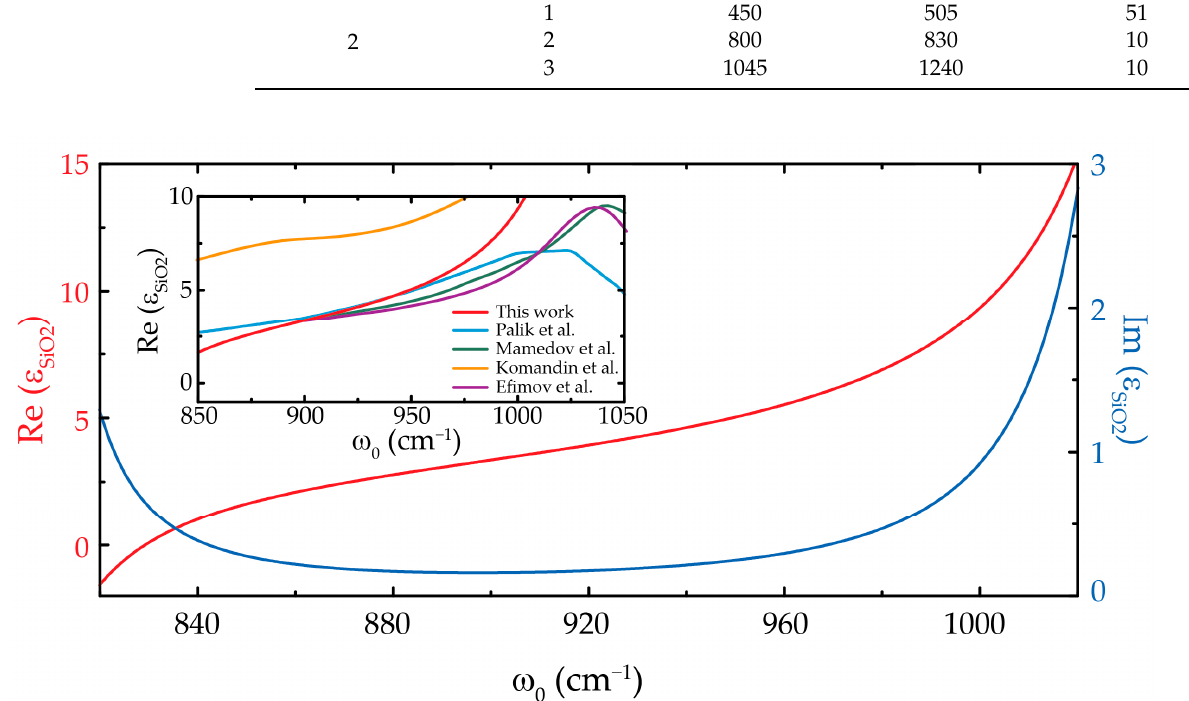
Figure 4. Experimental IR complex dielectric function of SiO 2 . The real and imaginary parts are depicted in blue and red, respectively. The inset shows a comparison of the extracted permittivity with others obtained from far-field measure- ments. Table 3. Parameters for the calculated IR complex dielectric function of SiO 2 .